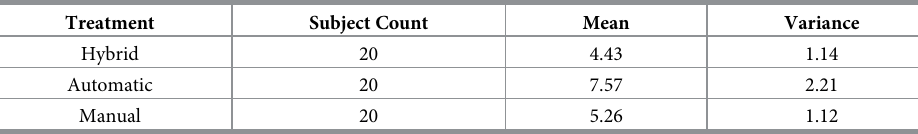
Table 7. Data summary—Group